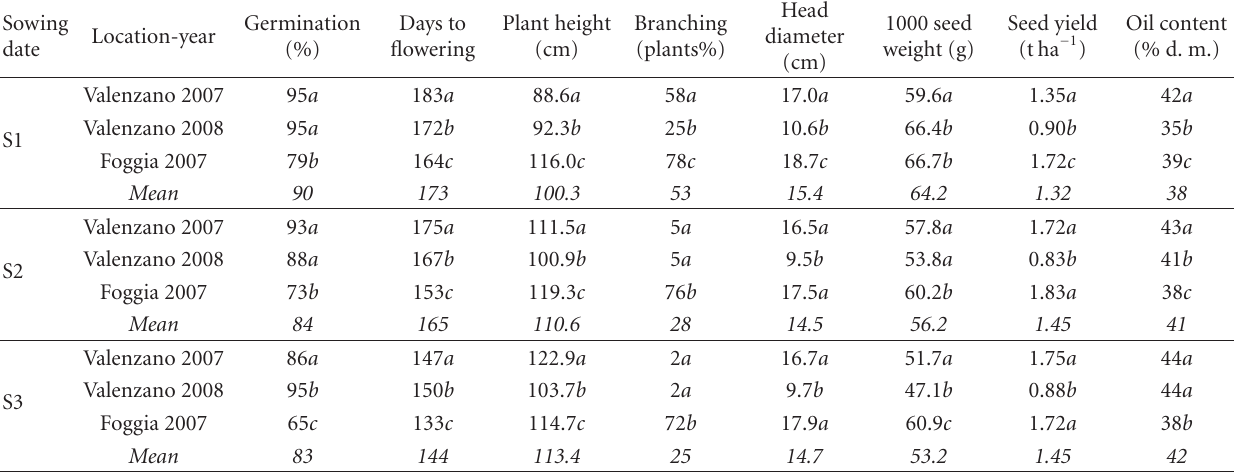
Table 4: Mean values of eleven sunflower hybrids for three anticipated sowing dates (S1, S2, and S3) in three location-year combinations for eight biometric traits.